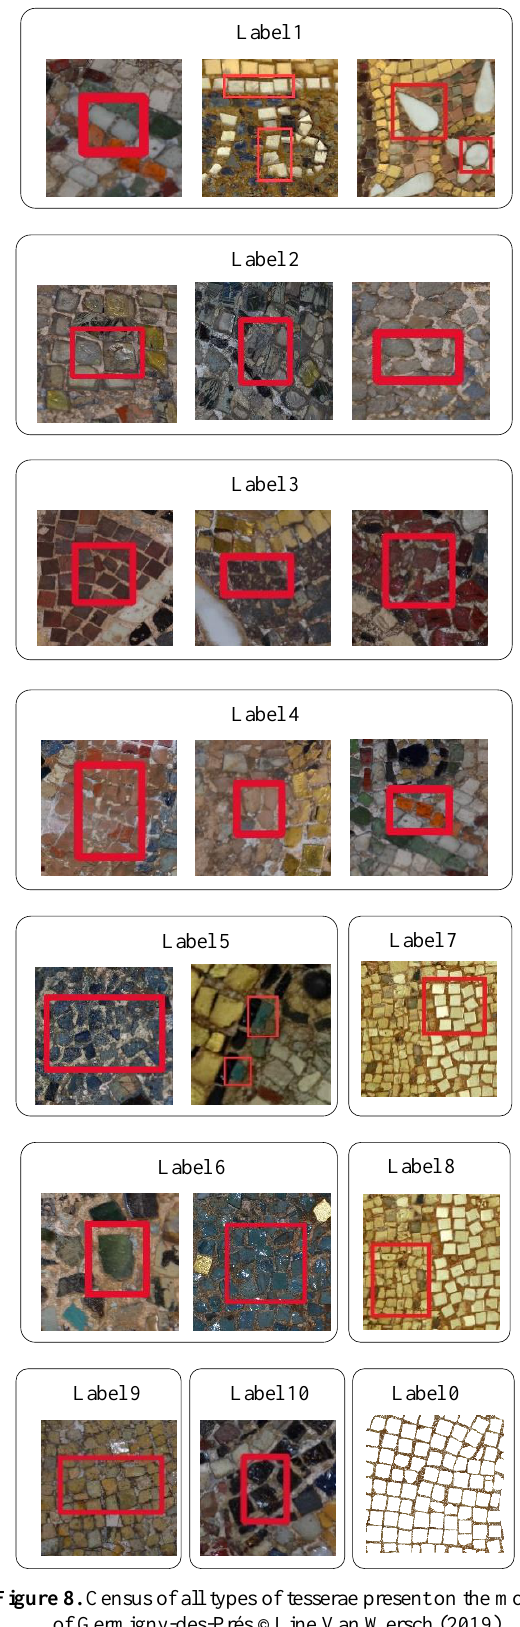
Figure 8. Census of all types of tesserae present on the mosaic of Germigny-des-Prés ©Line Van Wersch